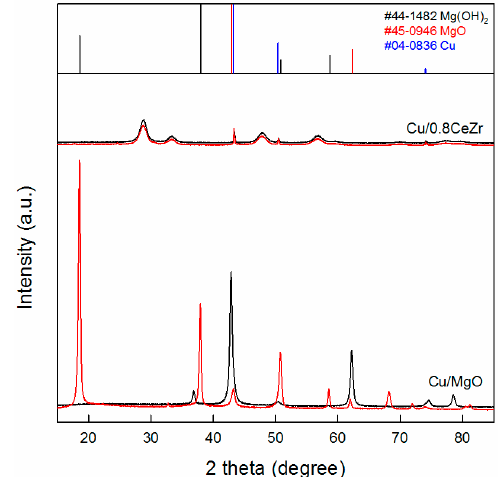
Figure 10. Powder X-ray diffraction patterns of fresh (black) and spent (red) Cu/0.8CeZr and Cu/MgO catalysts. The reflections of Mg(OH) 2 (black bars), MgO (red bars), and Cu metal (blue bars) are included for peak